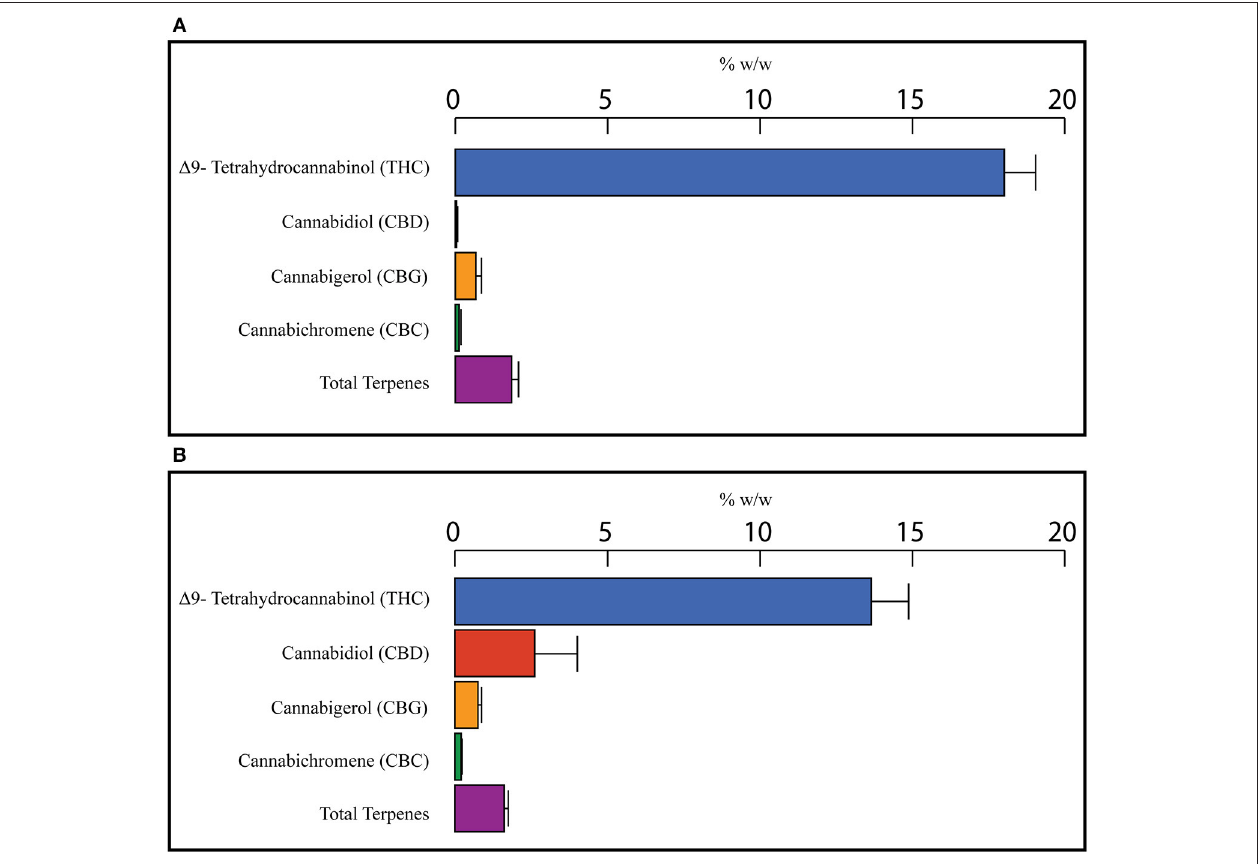
FIGURE 3 | Weighted average cannabinoid and total terpene concentrations for the top four most effective (A) and top four least effective (B) cannabis strains as rated by medical marijuana patients. Patients were asked to select the cannabis strain(s) that were the most effective or least effective for the treatment of their anxiety. Selected Strains were analyzed for the concentration of cannabinoids and terpenes and weighted average values for the most and least effective groups calculated using the number of votes as a weighting